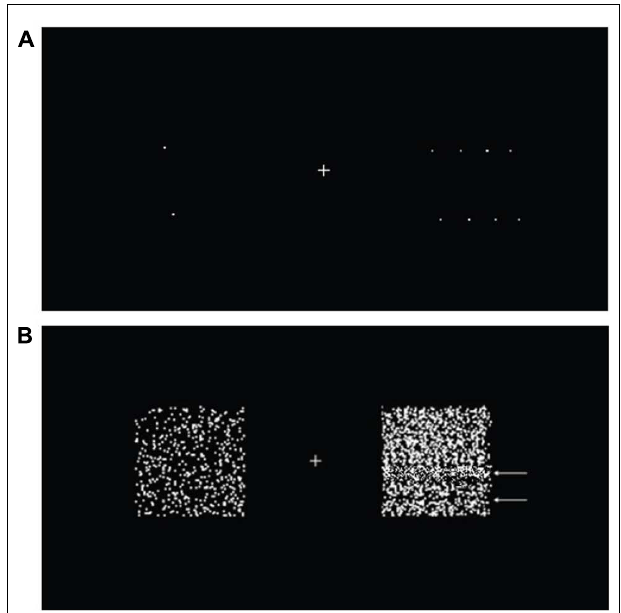
FIGURE 5 | A simulation of subjects’ perception of motion streaks. A slow non-streaky up–down motion (2 ◦ /s) was presented on the left, and a fast streaky left–right motion (60 ◦ /s) on the right. (A) Two dots produced strong motion streaks.The smoothness of motion was limited by the refresh rate of the screen (60 Hz), and at very high speeds, the dots would simply “jump” from one point to another without a smooth transition.This resulted in the appearance of multiple widely spaced dots. At very high speed above 80 ◦ /s the dots appeared to merely flicker, and motion was difficult if not impossible to perceive. (B) For the 500-dot stimuli, banding (white arrows) could be observed in some of the fast motion trials (5 ◦ s − 1 above individual subject’s threshold) due to random heterogeneity in the dot pattern.The after-images from fast motion also resulted in a denser random dot pattern as compared to the slow